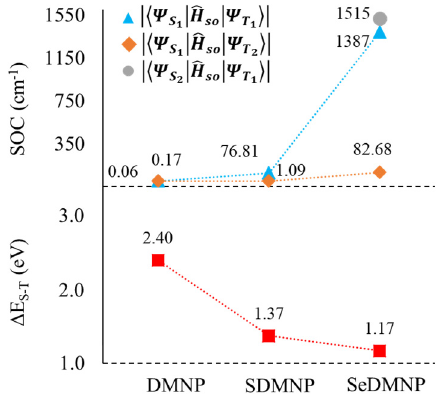
Figure 6. Computed SOC values (cm − 1 ) and singlet–triplet splitting ( ∆ S-T , eV) for DMNP, SDMNP, and SeDMNP.